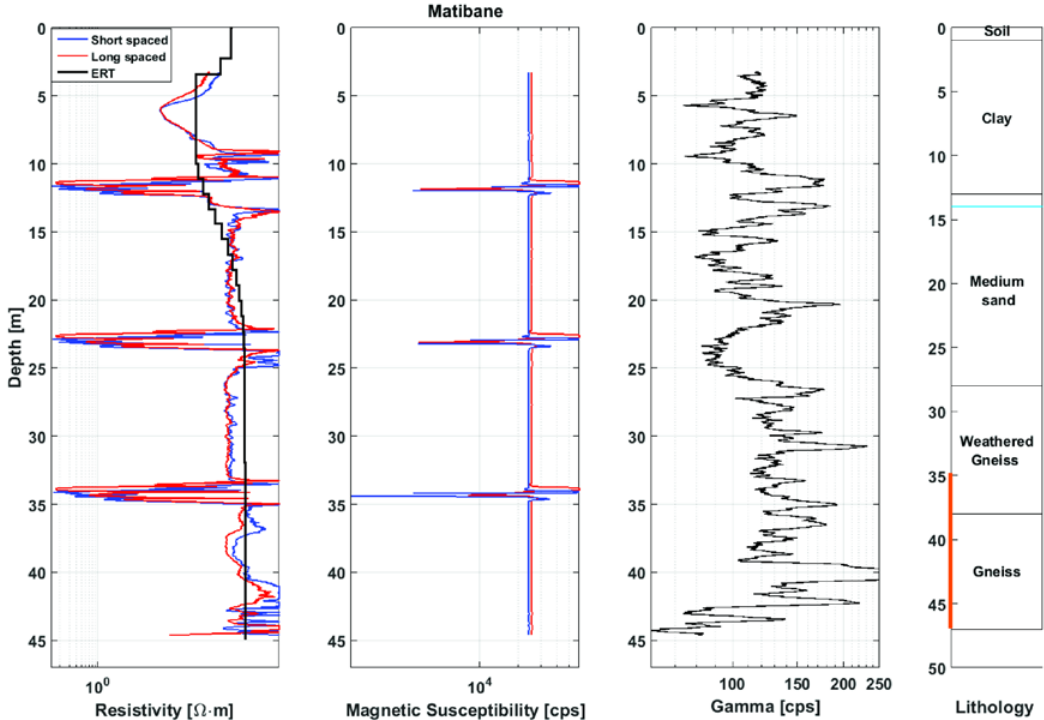
Figure 4. Borehole logging at Matibane community with result of resistivity, magnetic susceptibility natural, gamma and lithology. Blue horizontal line—water level and orange vertical line—well-screen placement (logging data from [18]).